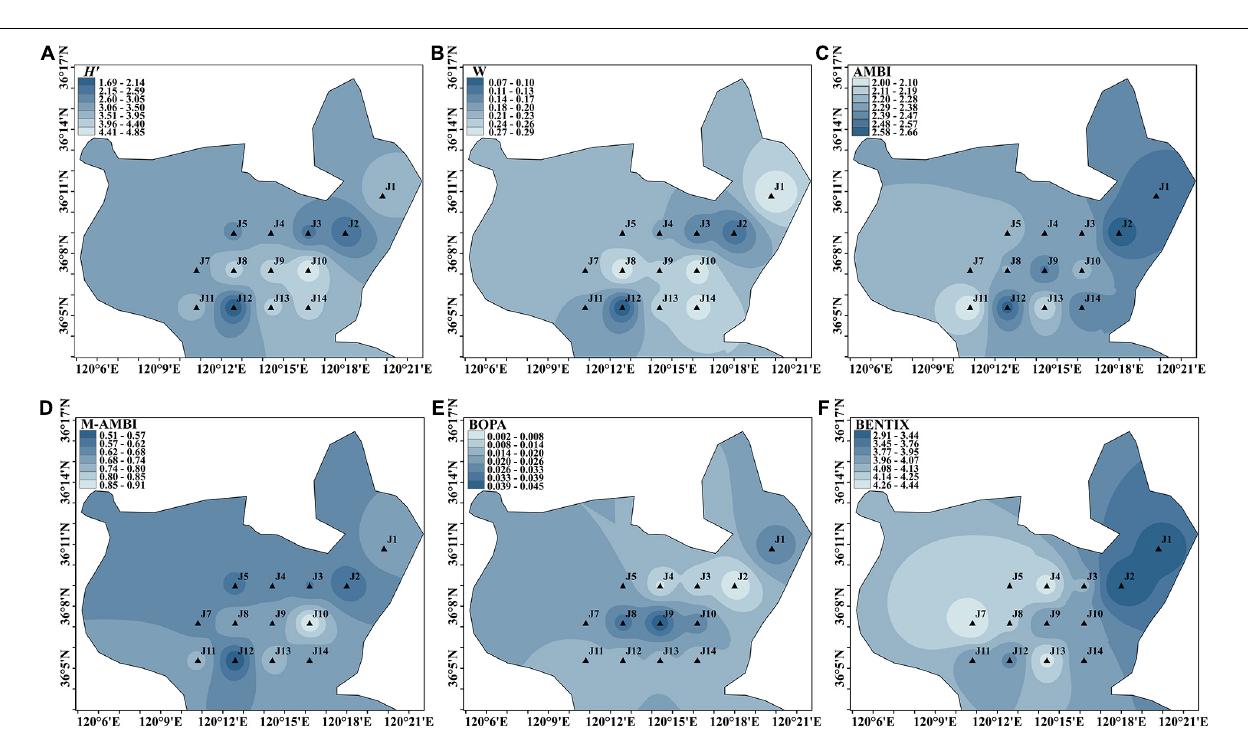
Frontiers in Marine Science |